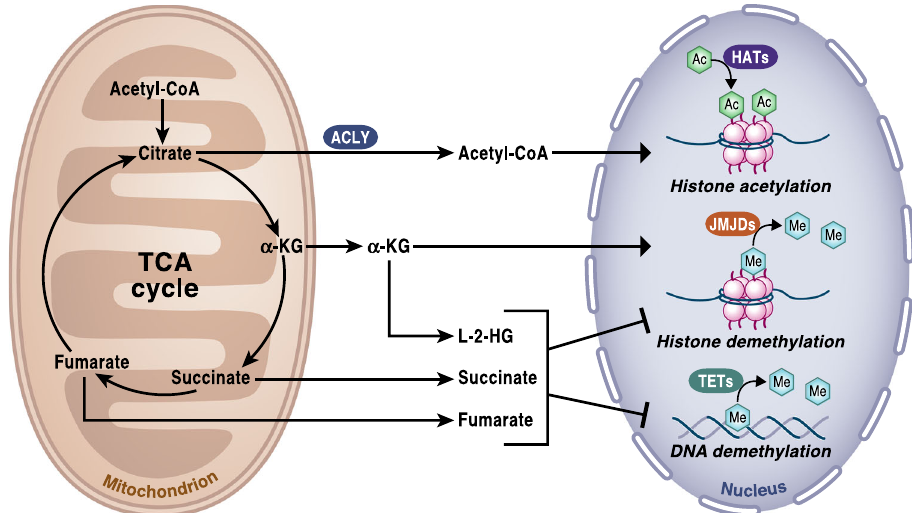
Fig. 4 TCA cycle regulation of chromatin modi fi cations and DNA methylation. The activity of the TCA cycle is essential to provide the metabolites that control chromatin modi fi cations and DNA methylation. Speci fi cally, histone acetylation by histone acetyltransferases (HATs) is dependent on the availability of acetyl-CoA, which provides the necessary acetyl groups to enable the reaction. Acetyl-CoA is produced in the cytosol by ACLY using citrate exported from the TCA cycle in mitochondria. α -ketoglutarate ( α -KG) is an essential cofactor of 2-OGDD, including the histone demethylases JMJDs and TET DNA demethylases. Succinate is the product of 2-OGDD enzymes reactions and thus, when it accumulates, it works as an antagonist of the reaction. 2-HG and fumarate can also rewire the epigenetic landscape of the cells through inhibition of histone and DNA